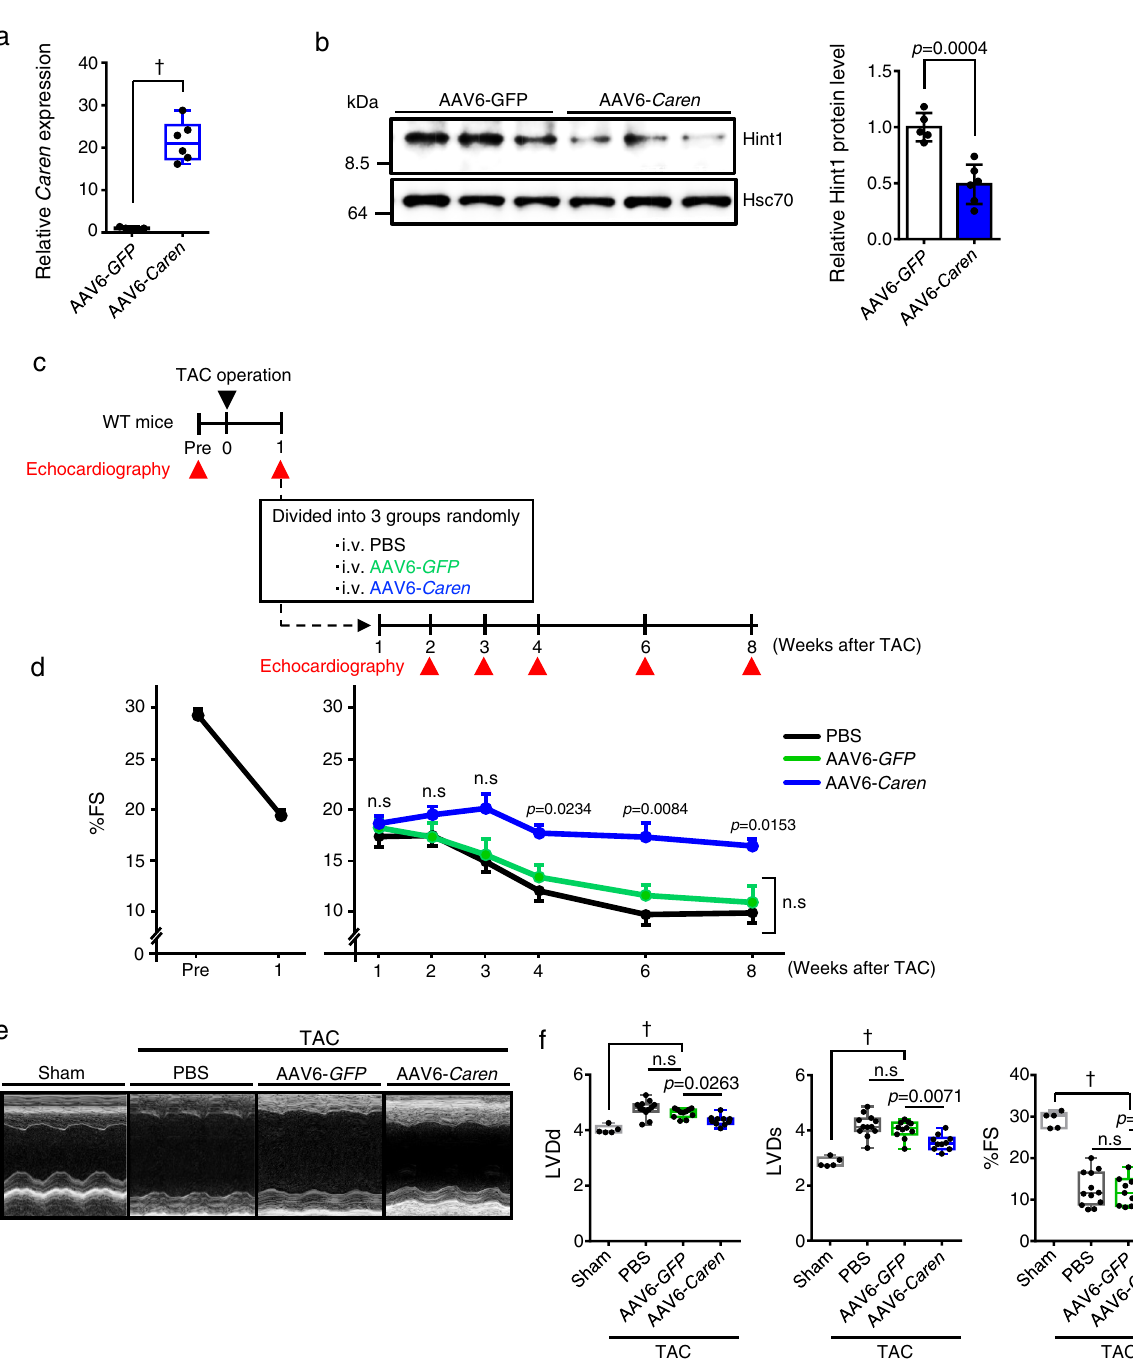
Fig. 8 Intravenous injection of AAV6- Caren slows the progression of heart failure in mice subjected to pressure overload. a Quanti fi cation of Caren expression in whole heart tissues of WT mice injected with 1 × 10 11 vg per mouse of AAV6- GFP or AAV6- Caren , 1 week after injection (AAV6- GFP : n = 5, AAV6- Caren : n = 6). Levels seen in the AAV6- GFP group were set to 1. b Representative western blots (left) and quantitation (right) of Hint1 protein levels in heart tissues of WT mice injected with 1 × 10 11 vg per mouse of AAV6- GFP or AAV6- Caren , 1 week after injection (AAV6- GFP : n = 5, AAV6- Caren : n = 6). Hsc70 served as the loading control. Protein intensity values in the AAV6- GFP group were set to 1. c Schematic showing experimental protocol. d Comparison of %FS between mice before (pre) and 1 week after TAC surgery ( n = 33) (left) and in TAC mice injected with PBS or 1 × 10 11 vg per mouse of AAV6- GFP or AAV6- Caren (sham: n = 5, PBS: n = 12, AAV6- GFP : n = 11, AAV6- Caren : n = 10) (right). e Representative M-mode echocardiography recordings in sham-operated and TAC-operated animals 7 weeks after injection of PBS, AAV6- GFP, or AAV6- Caren . f Left ventricular end-diastolic diameter (LVDd) (mm) (left), left ventricular end-systolic diameter (LVDs) (mm) (middle), and percent fractional shortening (%FS) (right) (sham: n = 5, PBS: n = 12, AAV6- GFP : n = 11, AAV6- Caren : n = 10). Box plots for a and f present min to max, median, and all points. Data show mean ± SD and all points for b . For d , data show mean ± SD. Statistical signi fi cance was determined by two-sided unpaired Student ’ s t -test ( a , b ) or one-way ANOVA with Sidak ’ s post hoc test ( d , f ). In d , the p -value show AAV6- GFP vs. AAV6- Caren . † p < 0.0001, n.s; not signi fi cant, between